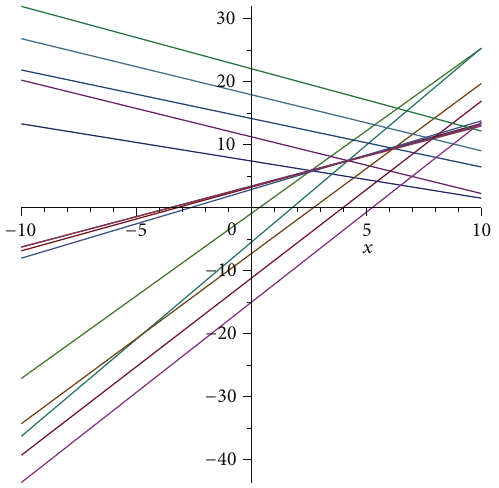
Figure 2: Simple linear regression equations for normal situation and forward and backward